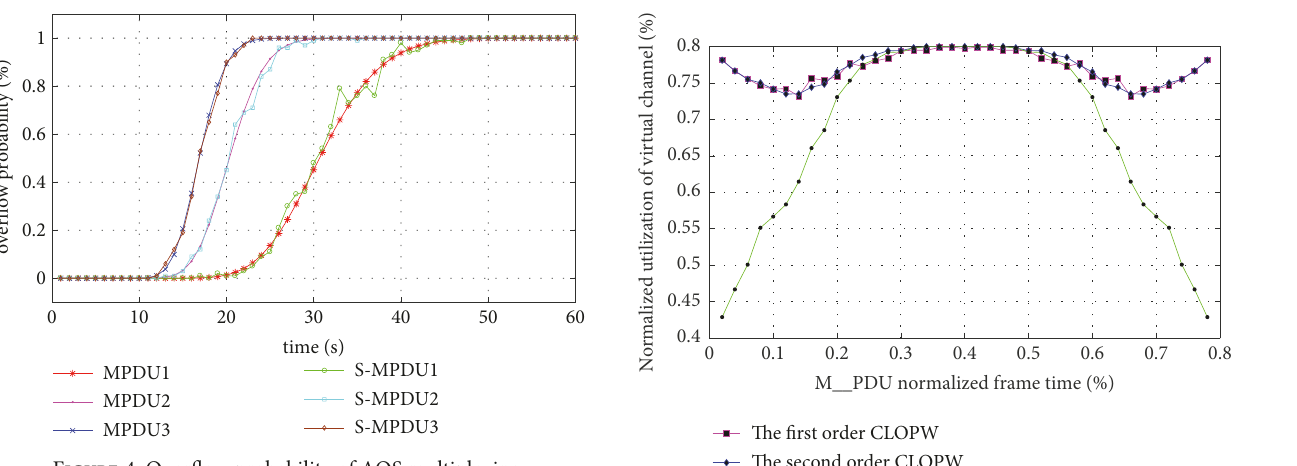
Figure 4: Overflow probability of AOS multiplexing.